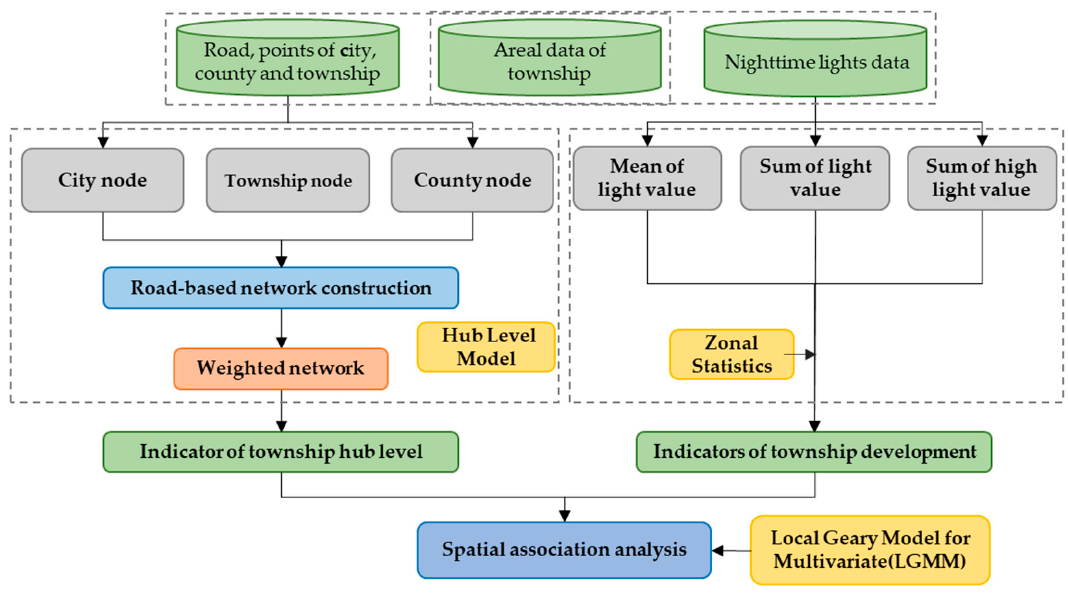
Figure 2. Research framework.